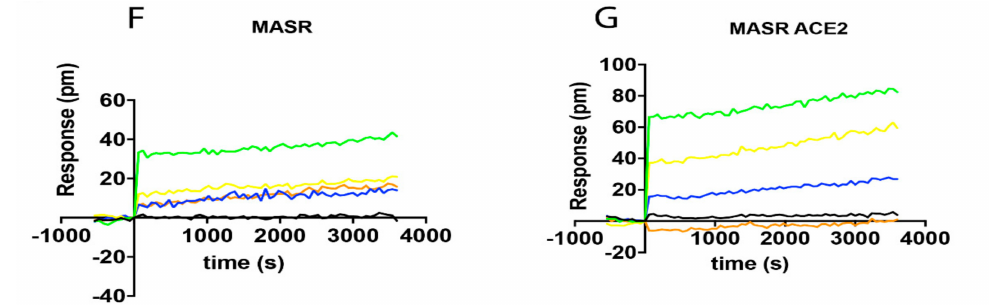
Figure 3. Impact of ACE2 on the functionality of MasR. HEK-293T cells were transfected with 0.5 µ